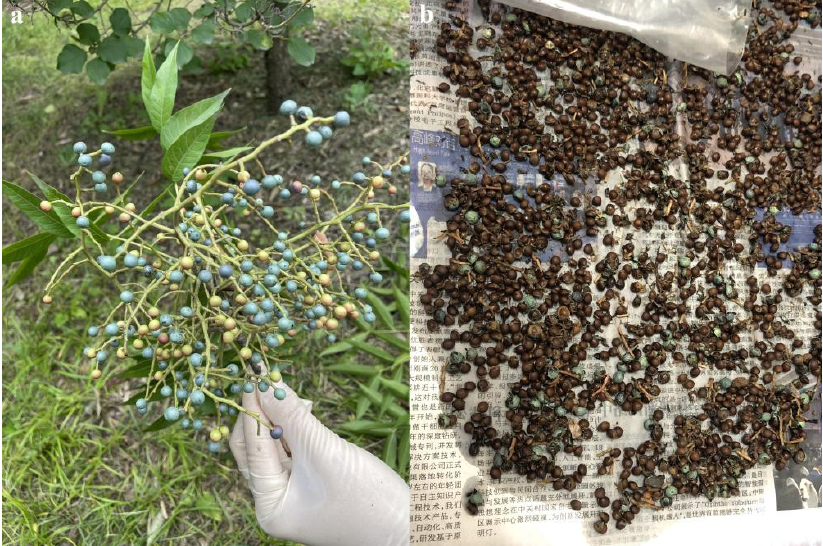
Figure 1. Harvested Chinese pistache seeds with the pericarp ( a ) and without the pericarp ( b ).